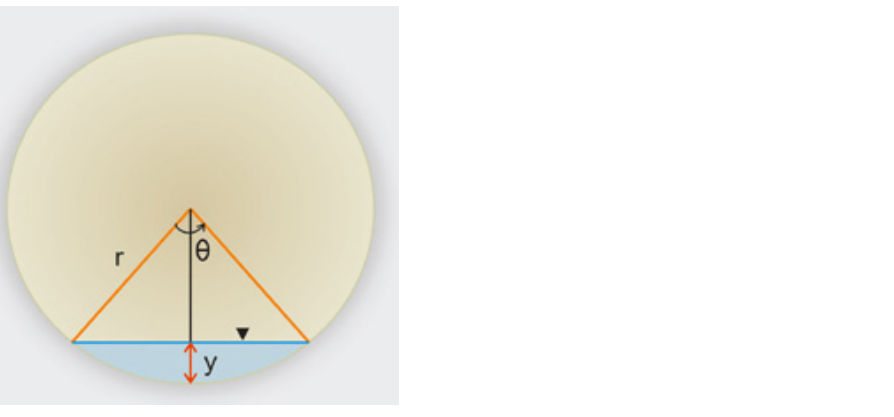
Figure A1. Geometric definition of radius (r), angle ( ϑ ) and water level (y) of a circular perimeter pipe.